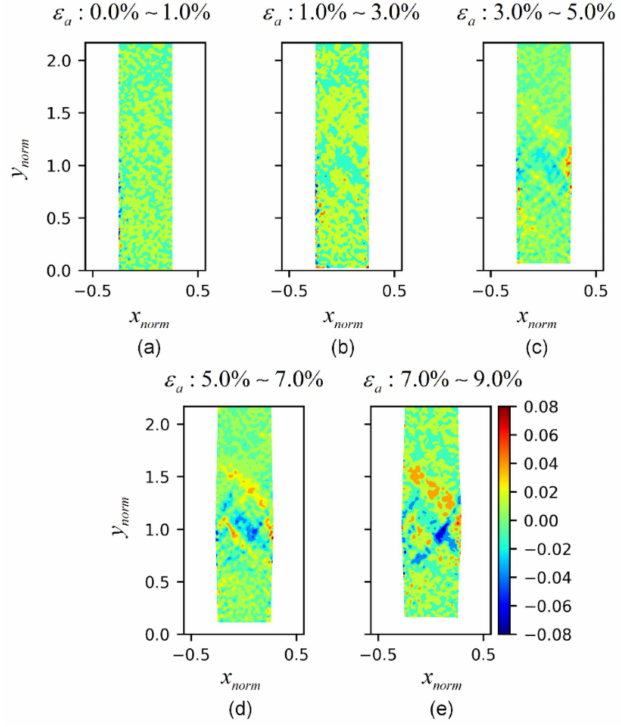
Figure 22. Evolution of curl along ˆ ρ axis ( curl U ) of test 121304b: ( a ) axial strain 0.0%–1.0%; ( b ) axial ρ strain 1.0%–3.0%; ( c ) axial strain 3.0%–5.0%; ( d ) axial strain 5.0%–7.0%; ( e ) axial strain 7.0%–9.0%.